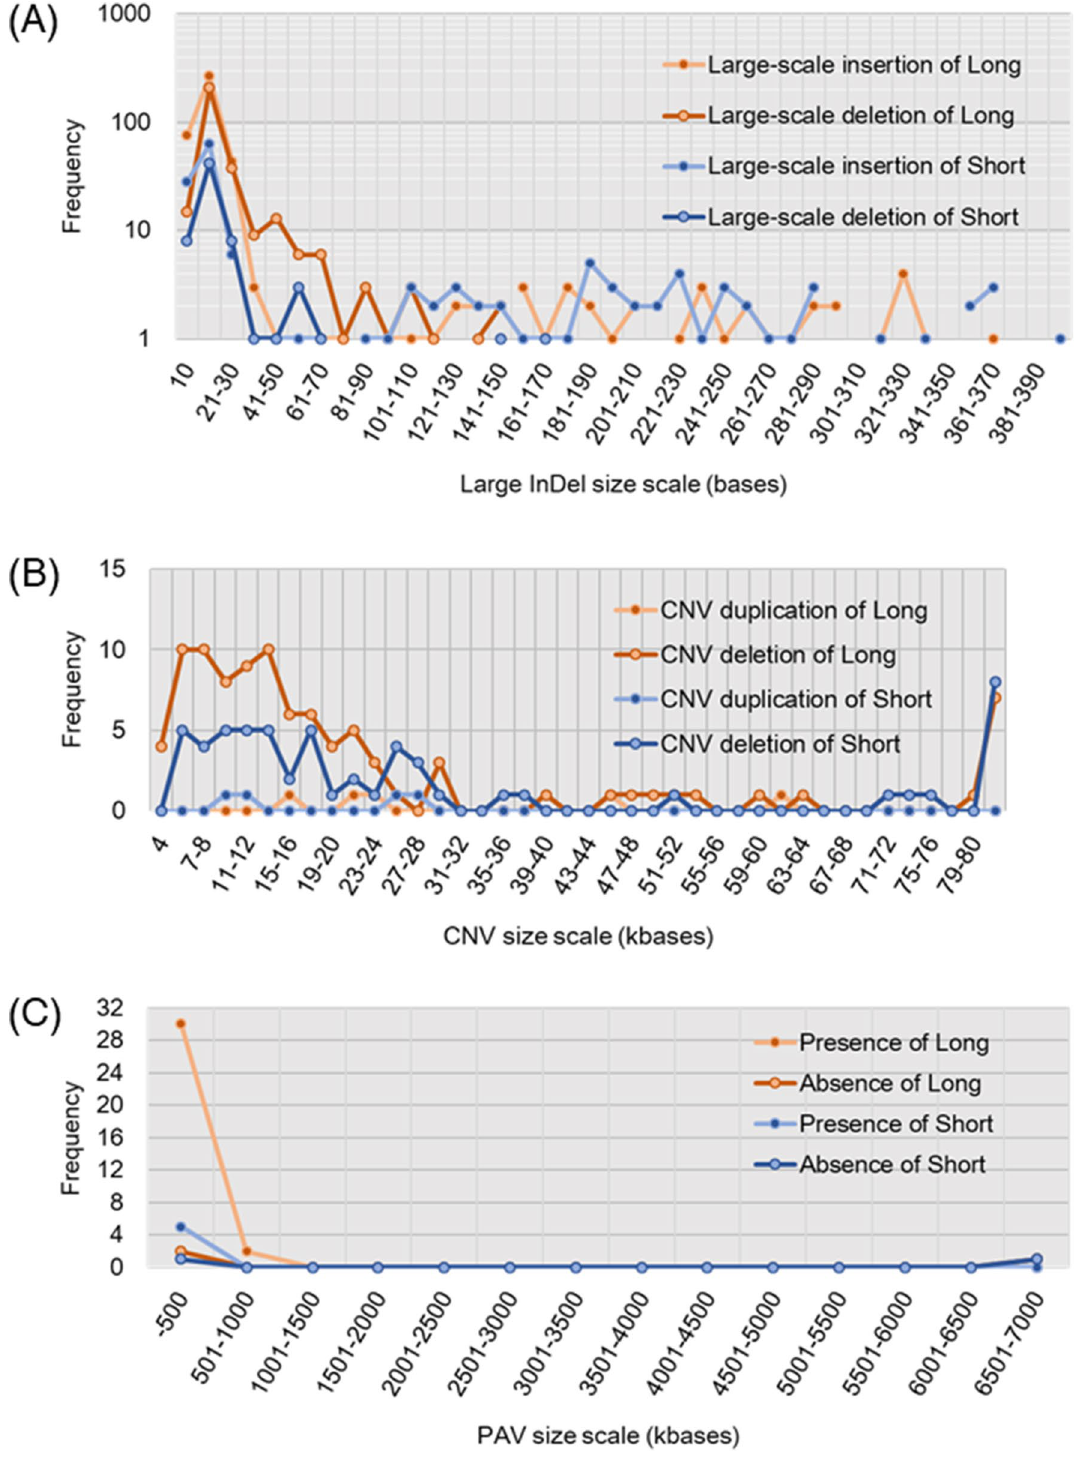
Figure 4. Structural variations including large-scale insertion and deletion (InDel) in a whole genome ( A ), copy number variation (CNV) ( B ), and presence/absence variation (PAV) ( C ) in long and short strains. Large- scale InDels were shown diagrammatically from 10 to 390 bases. CNV duplication and deletions were shown diagrammatically from 4 to 80 kbases. PAV were shown diagrammatically from 0 to 7000